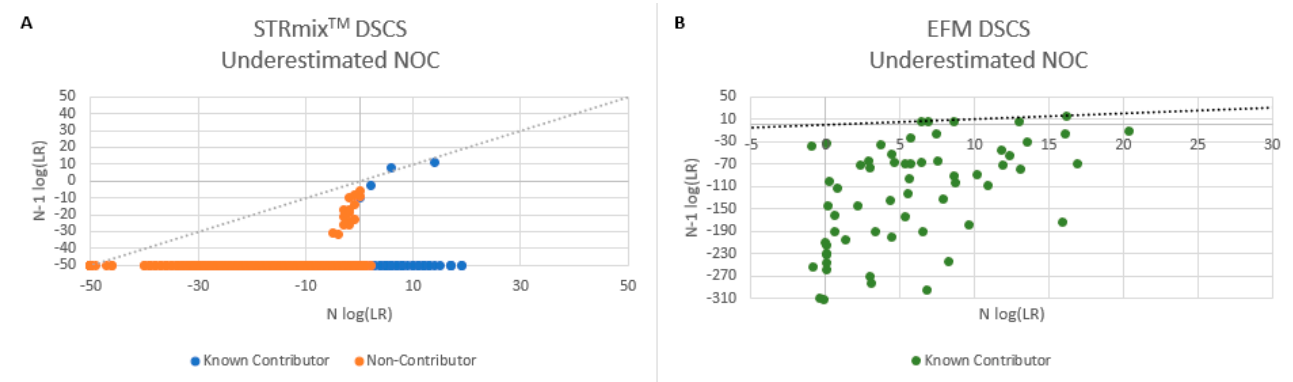
Figure 13. Underestimating the number of contributors to 2-cell DSCS mini-mixtures. ( A ) STRmix TM ; ( B ) EuroForMix; Note: Non-contributor pro fi les were not run with EFM. LR = 0 plo tt ed as − 50.